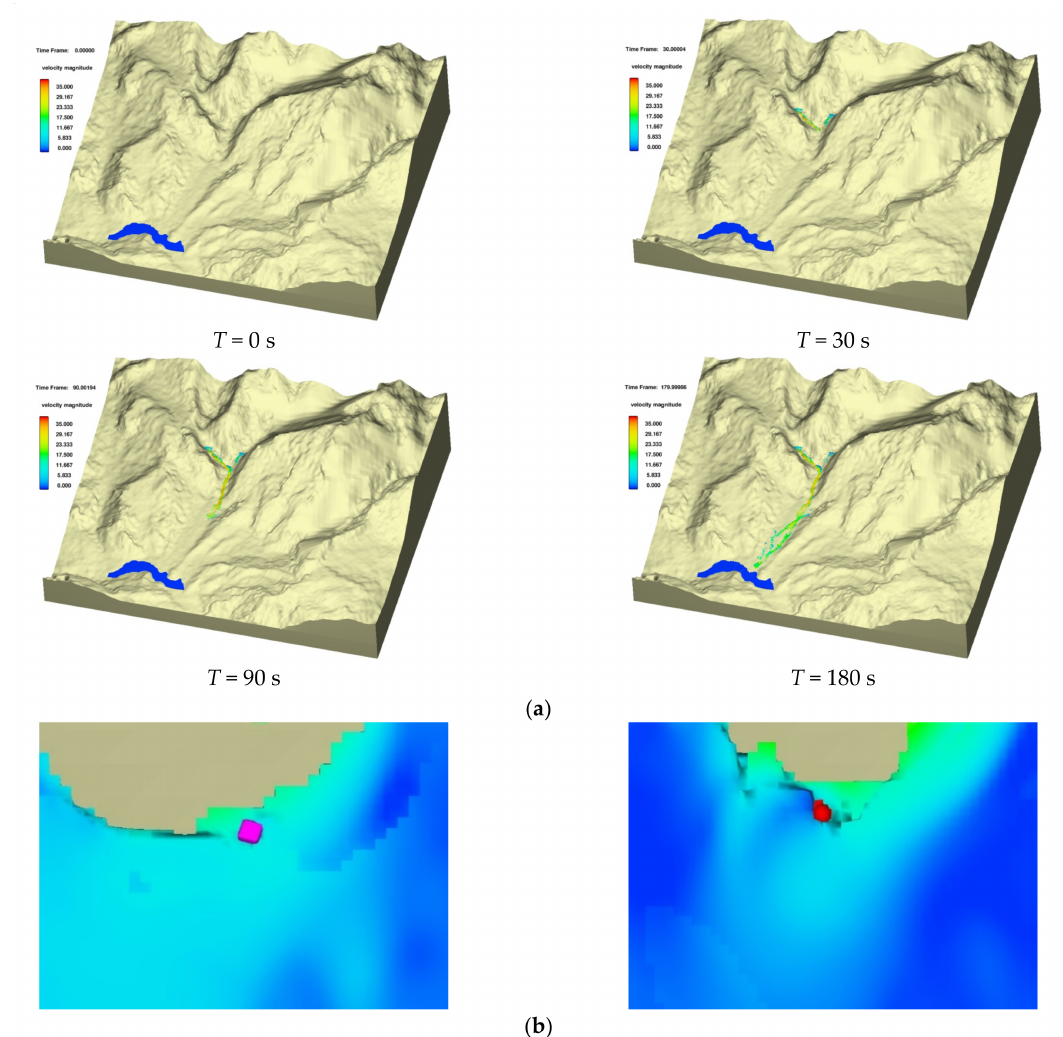
Figure 6. Simulation results. ( a ) instantaneous images of debris flow and boulder movement at different times for a debris flow of 2100 kg/m 3 ; ( b ) snapshots of cube and spherical boulders flowing into the river for a debris flow of 2100 kg/m 3